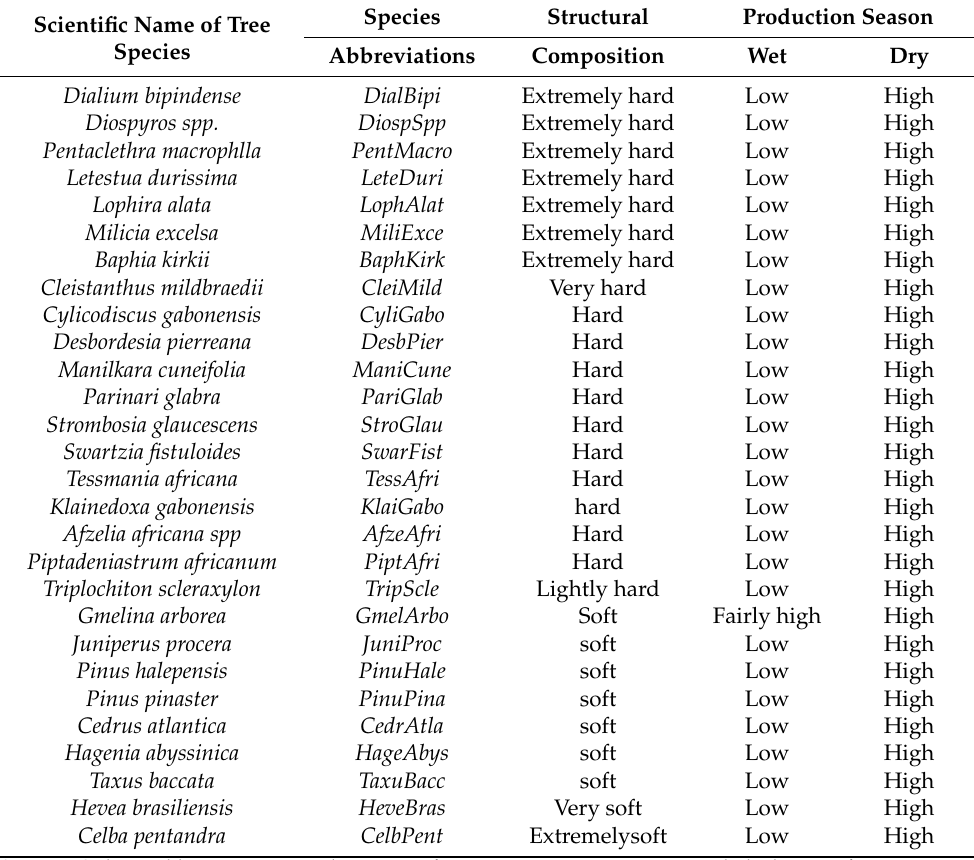
Table 4. Common tree species used for the production of wood charcoal in Africa